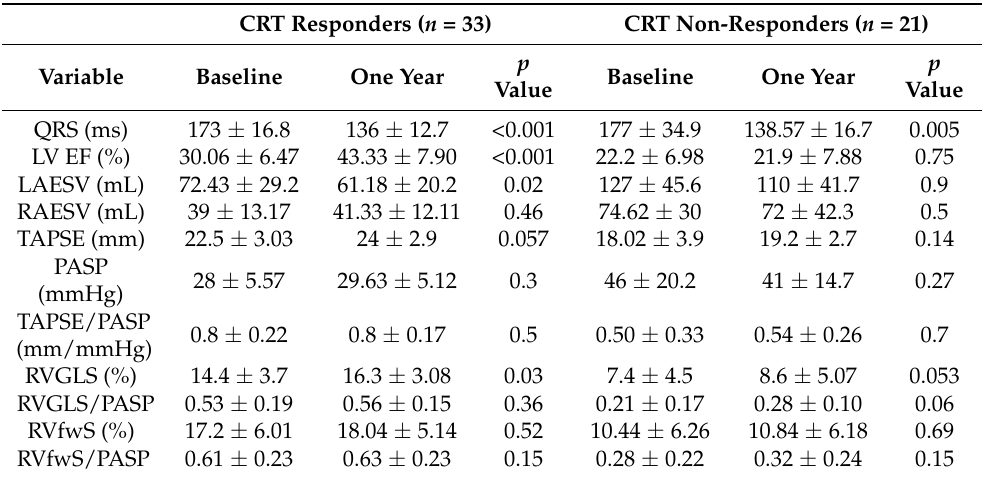
QRS: Duration of the QRS complex in the electrocardiogram, LVEF: left ventricular ejection fraction, LAESV: left atrium end systolic volume, RAESV: right atrium end systolic volume, PASP: pulmonary artery systolic pressure, TAPSE: tricuspid annular plane systolic excursion, RVGLS: RV global longitudinal strain, PASP: pulmonary artery systolic pressure, RVfwS: RV free wall strain. Using ROC curves analysis, we reported the predictive value for CRT response for dif- ferent variables. RVGLS/PASP reported an AUC = 0.88, 95% CI [0.77–1] and RVfwS/PASP an AUC = 0.87, 95% CI [0.72–1], shown in Figure